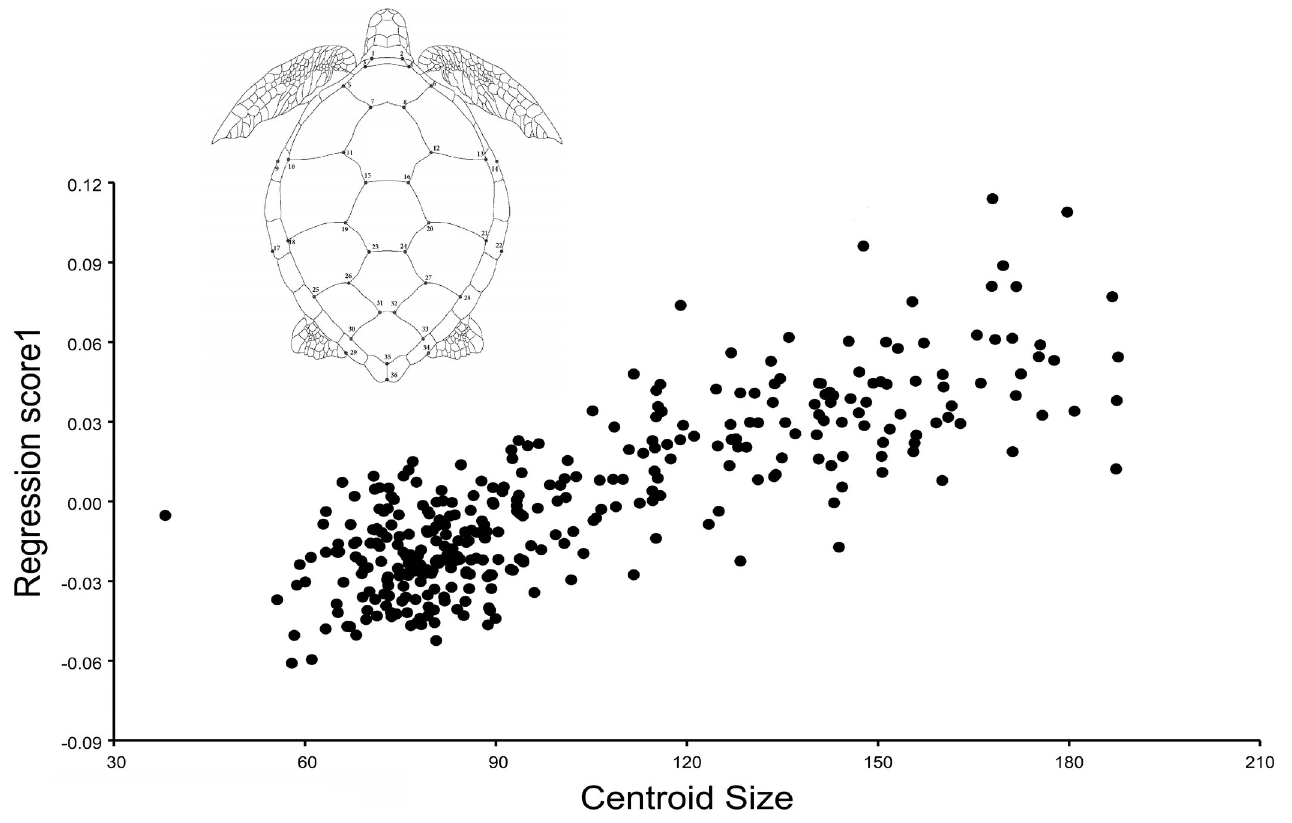
Fig 2. Multivariate regression of the carapace shape on carapace centroid